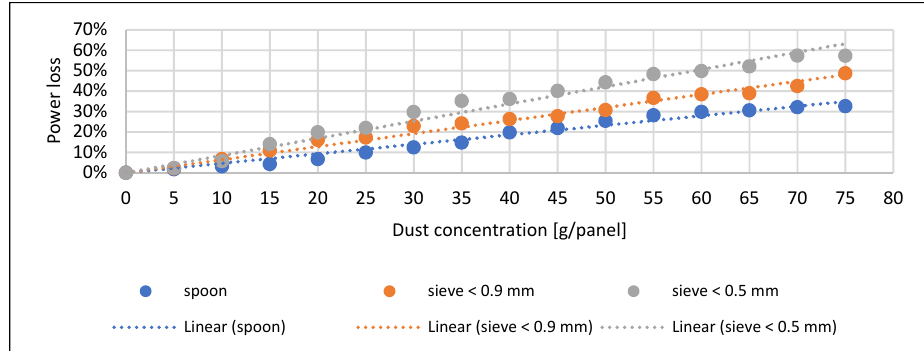
Figure 5. The short ‐ circuit current values as a function of the soil concentration.